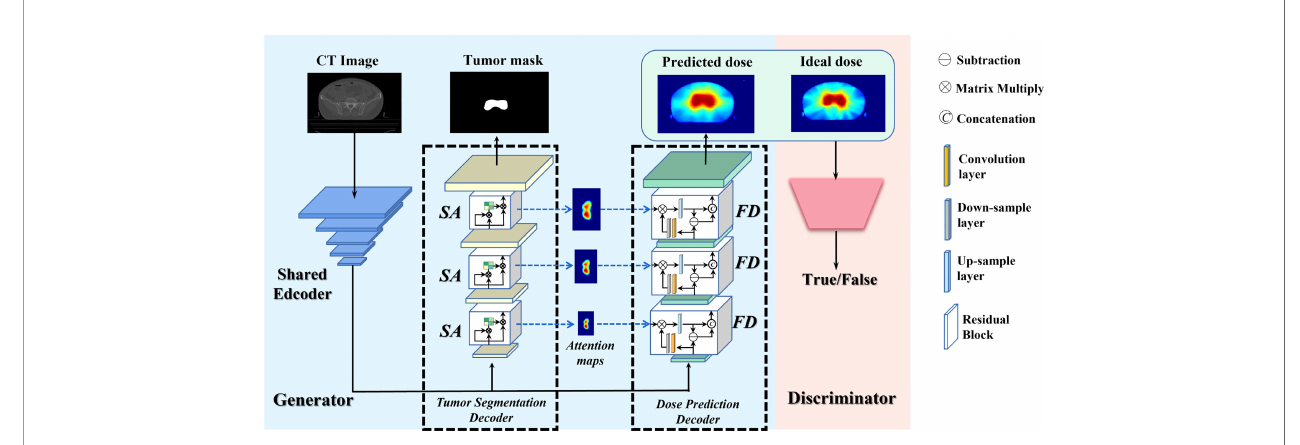
FIGURE 1 | Architecture of the proposed CT-only automatic dose